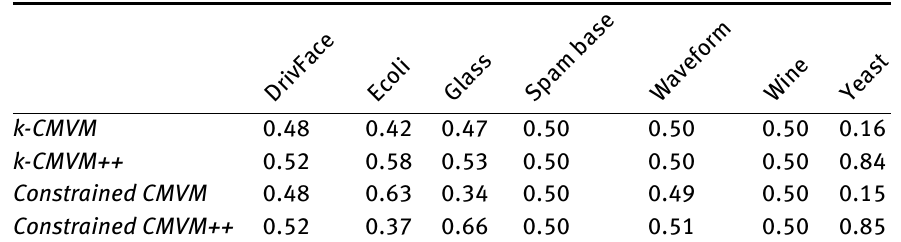
Table 6: Structural utility